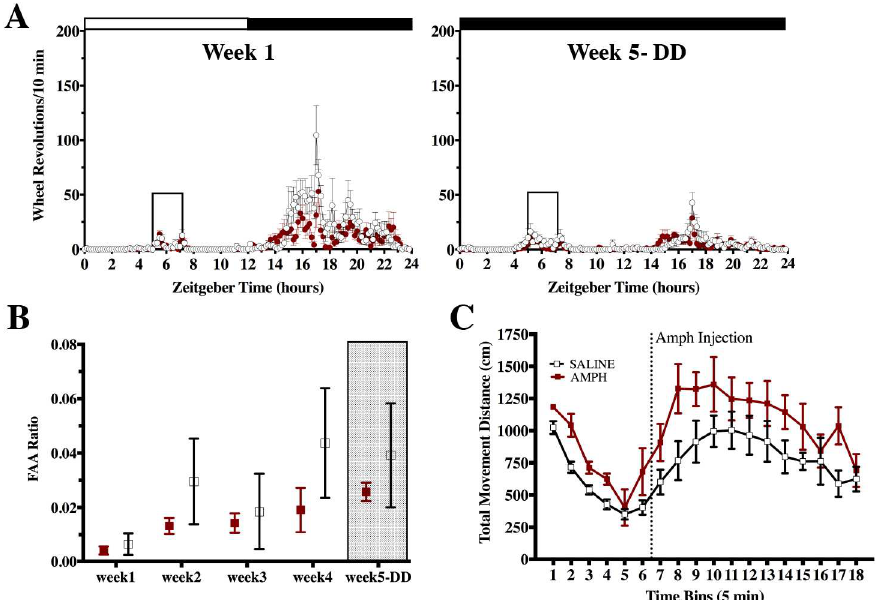
Fig 6. Exp 3: measuring FAA to a RT in rats previously exposed to AMPH or saline injections, between group design. Home-cageactivity of AMPH and saline pretreatedrats subjectedto RT duringweek 1 and week 5 (constant darkness, DD), expressedin wheel revolutions /10 min +/- SEM, closed box indicates feedingwindow( A ). FAA ratios +/- SEM for each week of RT ( B ). Open-fieldactivity measuredas total movement distance+/- SEM in 5 min bins for AMPH and salinepretreatedrats injectedwith AMPH ( C ).